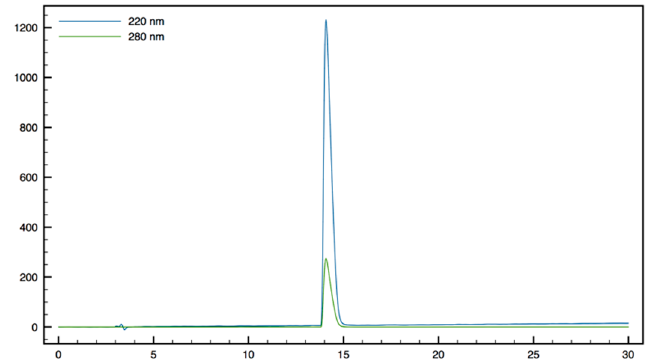
β 2,2 h bis-Arg-OMe 12 . Molecules 2019 , 24 , x FOR PEER REVIEW